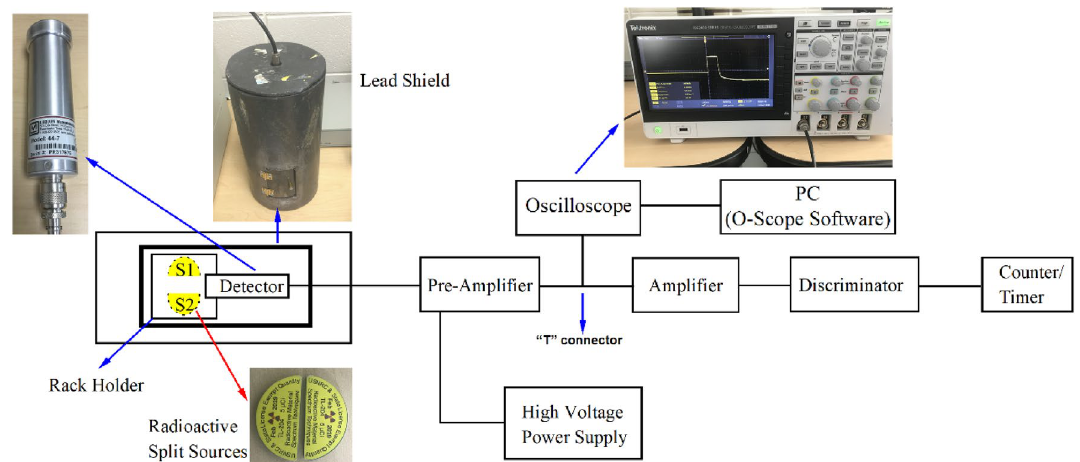
Figure 2. A schematic of the experimental setup for the radiation counting